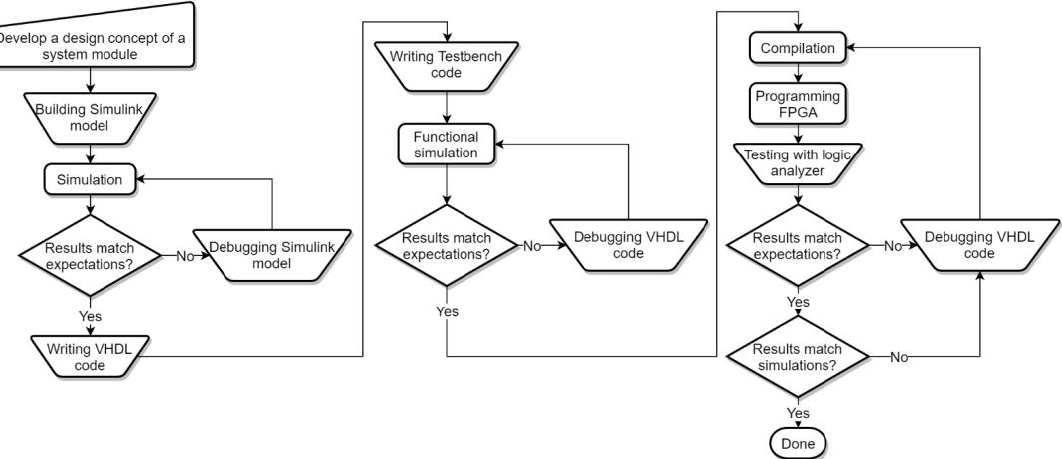
Figure 8. Flowchart of the design methodology for the FPGA implementation of prototype modules.